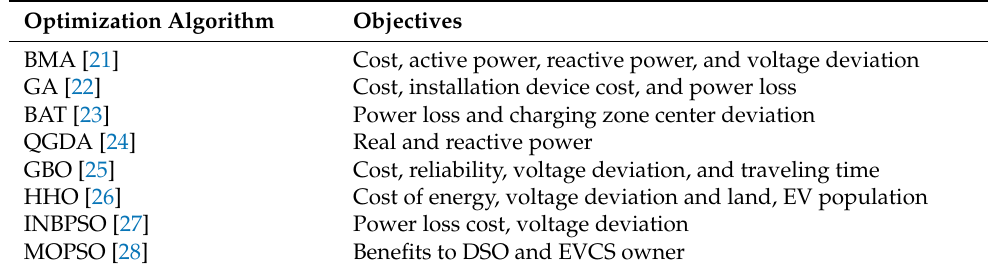
Table 1. Recent literature on solving the charging station placement problem. Optimization